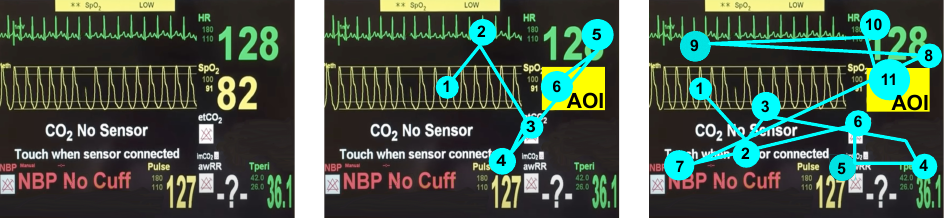
Figure 5. Left : Cardiac monitor used to perform the experiment. Middle : The course of the fixation trajectory of the respondents in a stress-free situation. Right : The course of the fixation trajectory of the respondents in a stressful situation. AOI—Area of interest (target place on the cardio monitor, where the patient’s vital signs fell), cyan spots—show the course of the subjects’ eye trajectories in the order from [1 to n].